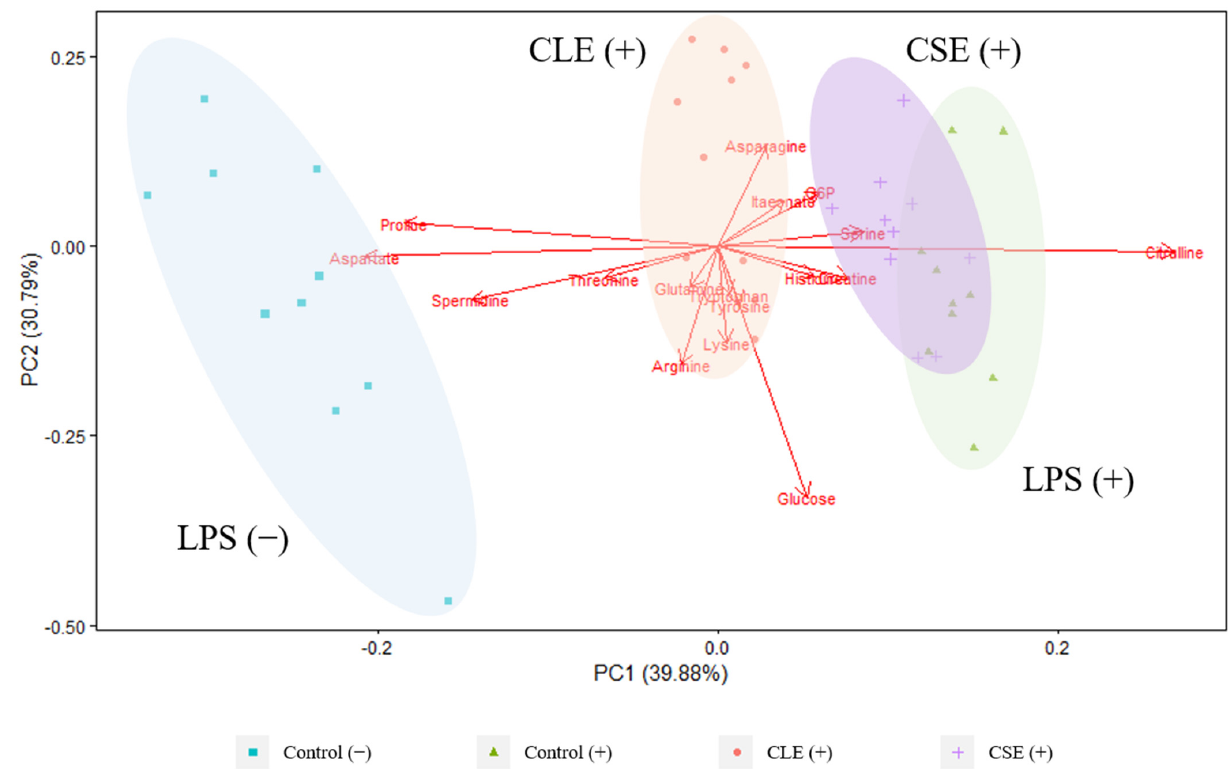
Figure 2. PCA biplot derived from LC-MS-targeted analysis of cell extracts from different treatment groups. (+) and ( − ) refer to LPS-stimulated and unstimulated cells, respectively. Red arrows represent metabolite loading vectors, and their distance from the origin indicates the extent of their influence on the PCs.